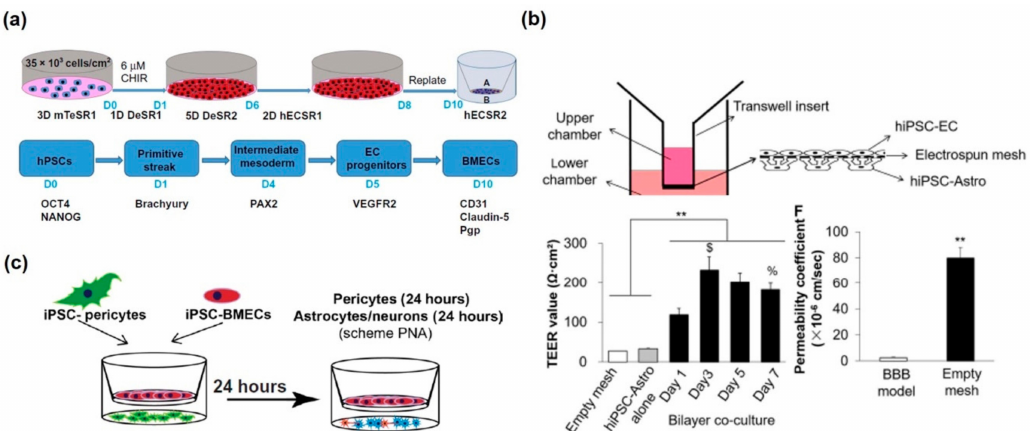
Figure 1. In vitro static blood–brain barrier (BBB) models. ( a ) 2D Transwell-based BBB model by human pluripotent stem cell (hPSC)-derived cells. Reproduced with permission from [37]. Copyright 2017, American Association for the Advancement of Science (AAAS). ( b ) 2D nanofiber-based BBB model by 3D printed holder and electrospun poly(lactic- co -glycolic acid) (PLGA) mesh and human induced pluripotent stem cell-derived cells for BBB. Reproduced with permission from [38].